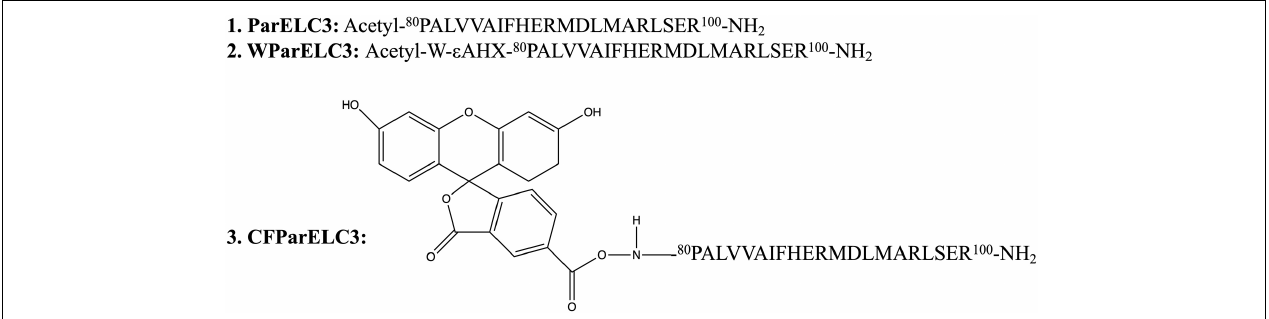
FIGURE 7 | Primary structure of synthetized peptides ( ε AHX = ε -aminocaproic